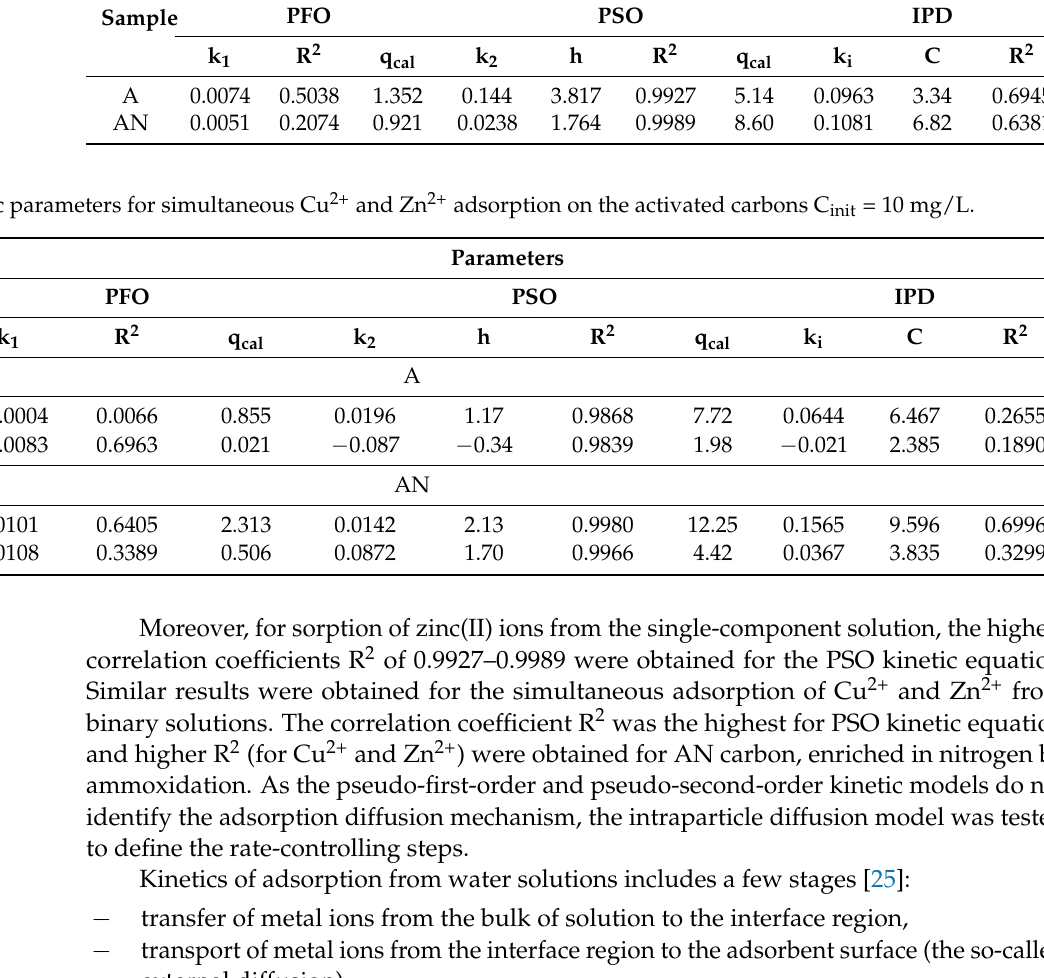
Table 3. Kinetic parameters for Zn 2+ adsorption on the activated carbons C init = 10 mg/L.